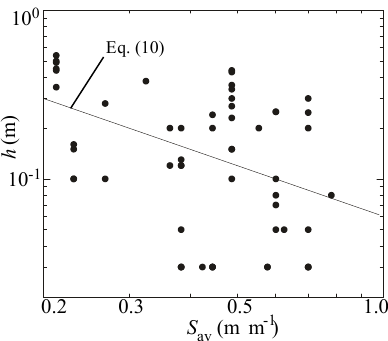
Figure 6. Plot of soil thickness, h , as a function of average slope, S av . The least-squares power-law fit to the data (Eq. 10) is also